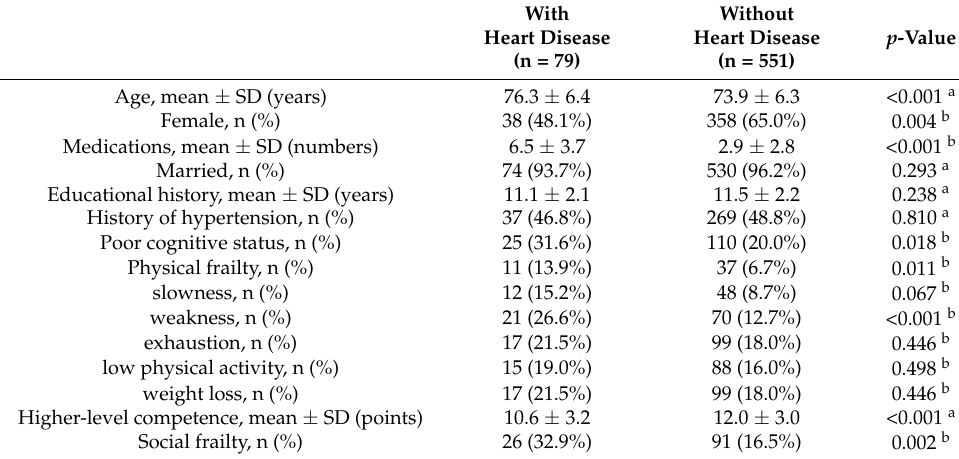
Table 1. Participant